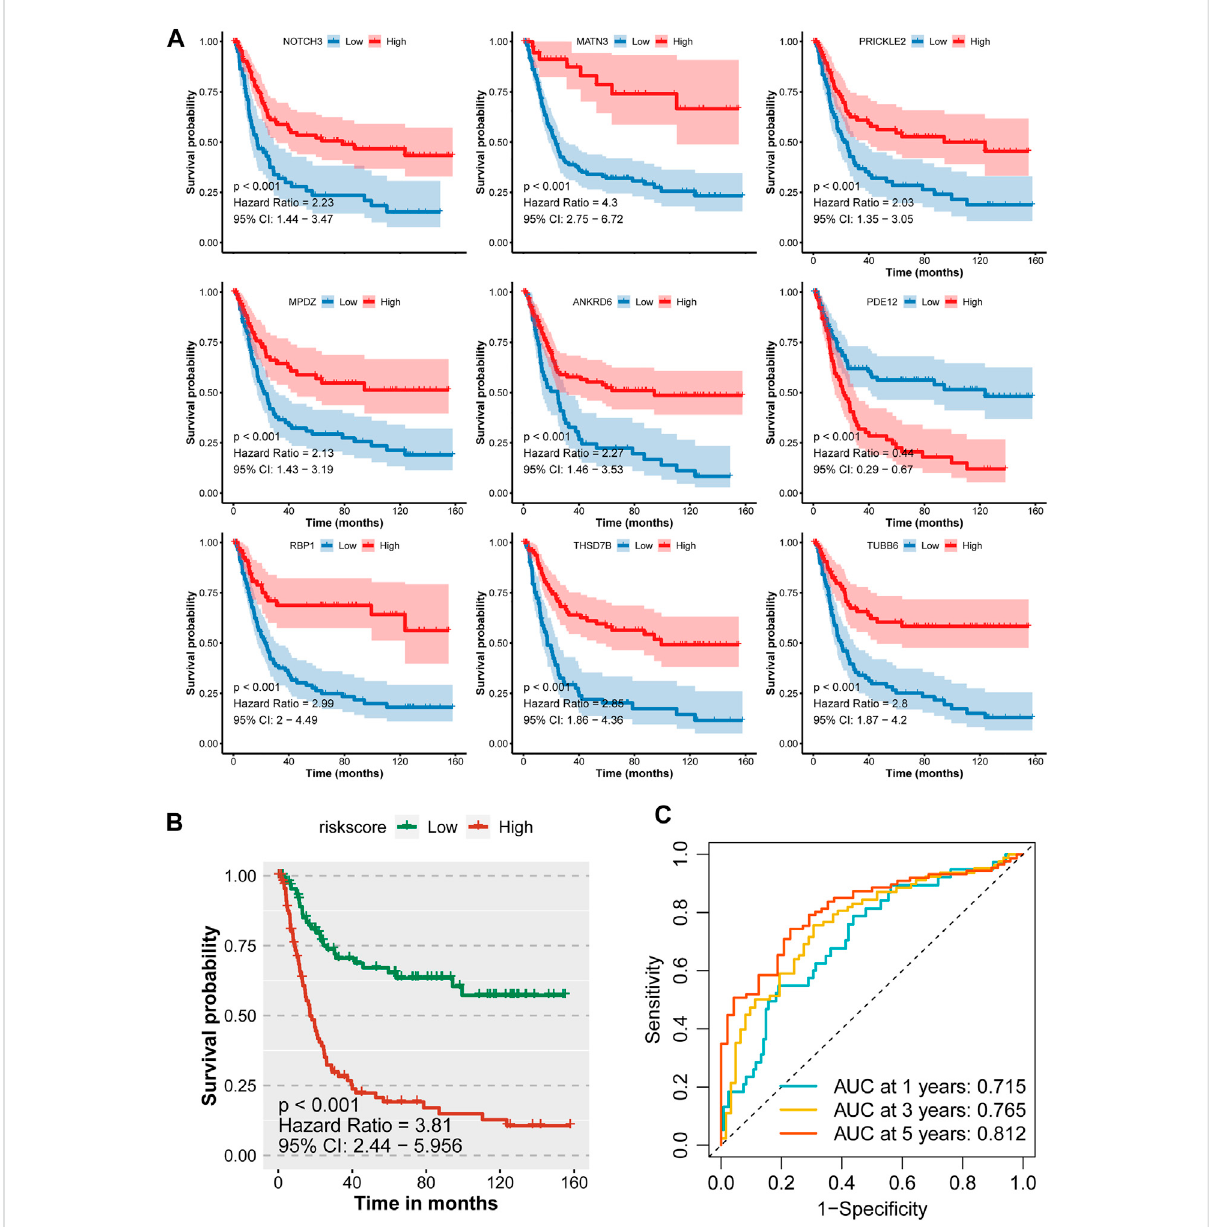
FIGURE 3 Prognostic value of the nine-consensus prognostic gene signature in the GSE15459 cohort. (A) , K-M plot showing the prognostic value of the nine selected genes; (B) , Kaplan – Meier curves for overall survival time of patients in the GSE15459 cohort. High-risk and low-risk groups were separated by the median value of risk score; (C) , Time-dependent ROC curves showing the predictive ef fi ciency of the risk signature for GC patients in the GSE15459